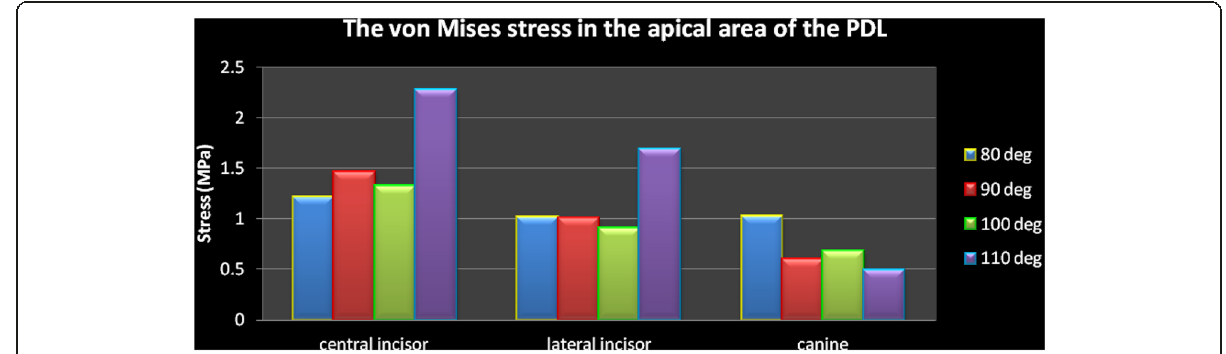
Fig. 10 The von Mises stress in the apical area of the PDL